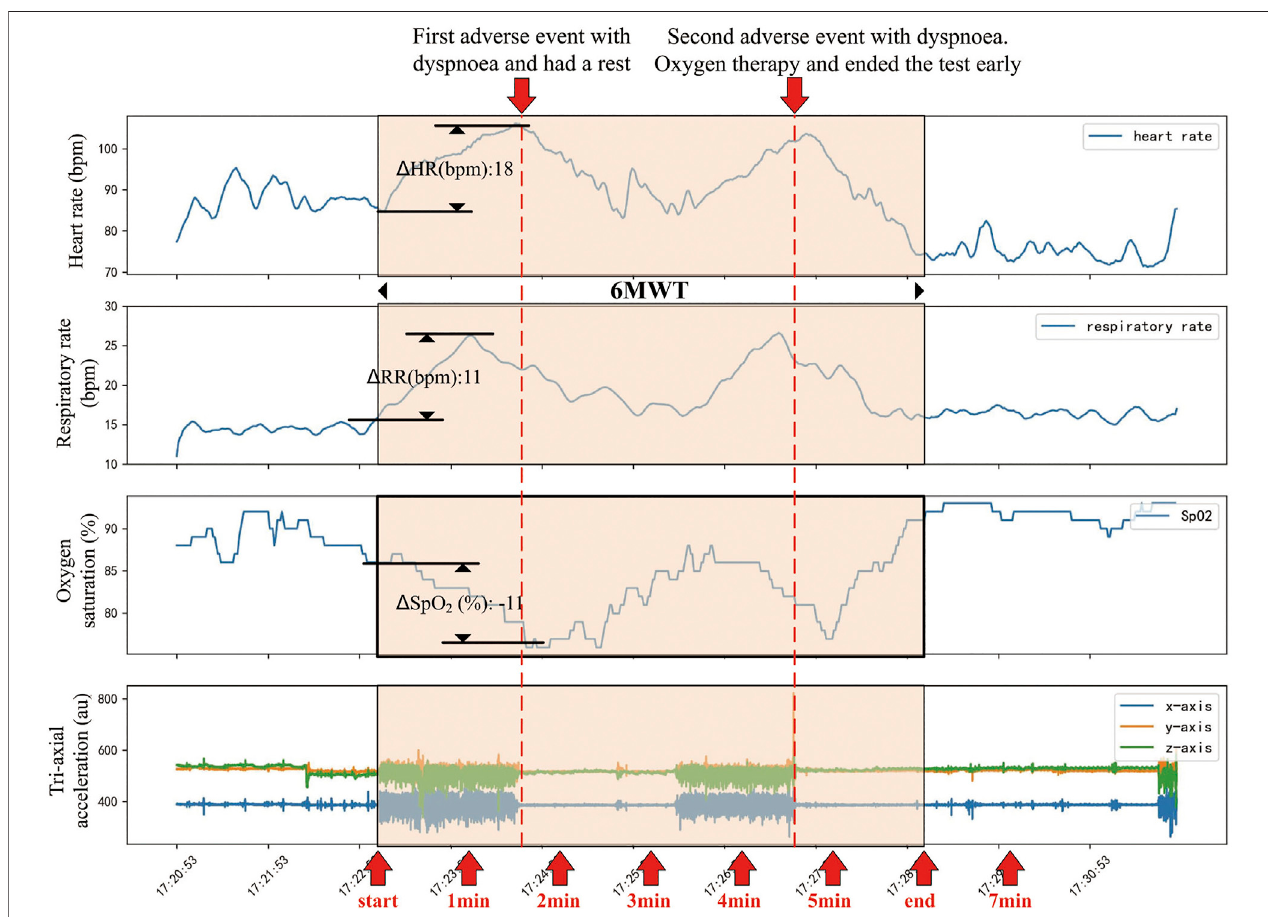
FIGURE 3 | An example of changes in physiological parameters of a patient before, during and after the 6MWT process. This patient had a rapid increase in heart rateandrespiratoryratewhilearapiddropinoxygensaturationfollowingthebeginningof6MWT.About90 safterthebeginningof6MWT,thepatienthadadyspneaand had a rest. During the rest period, the patient ’ s heart rate, respiratory rate and oxygen saturation recovered. About 280 s after the beginning of 6MWT, the patient developed a more severe intolerable dyspnea and was treated with oxygen. The 6MWT was terminated about 80 s early.